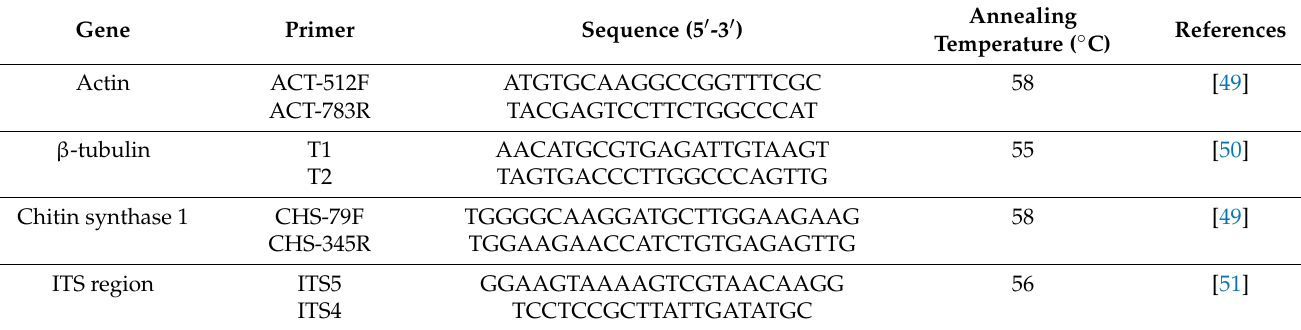
Table 3. Primers used in this study with sequences and